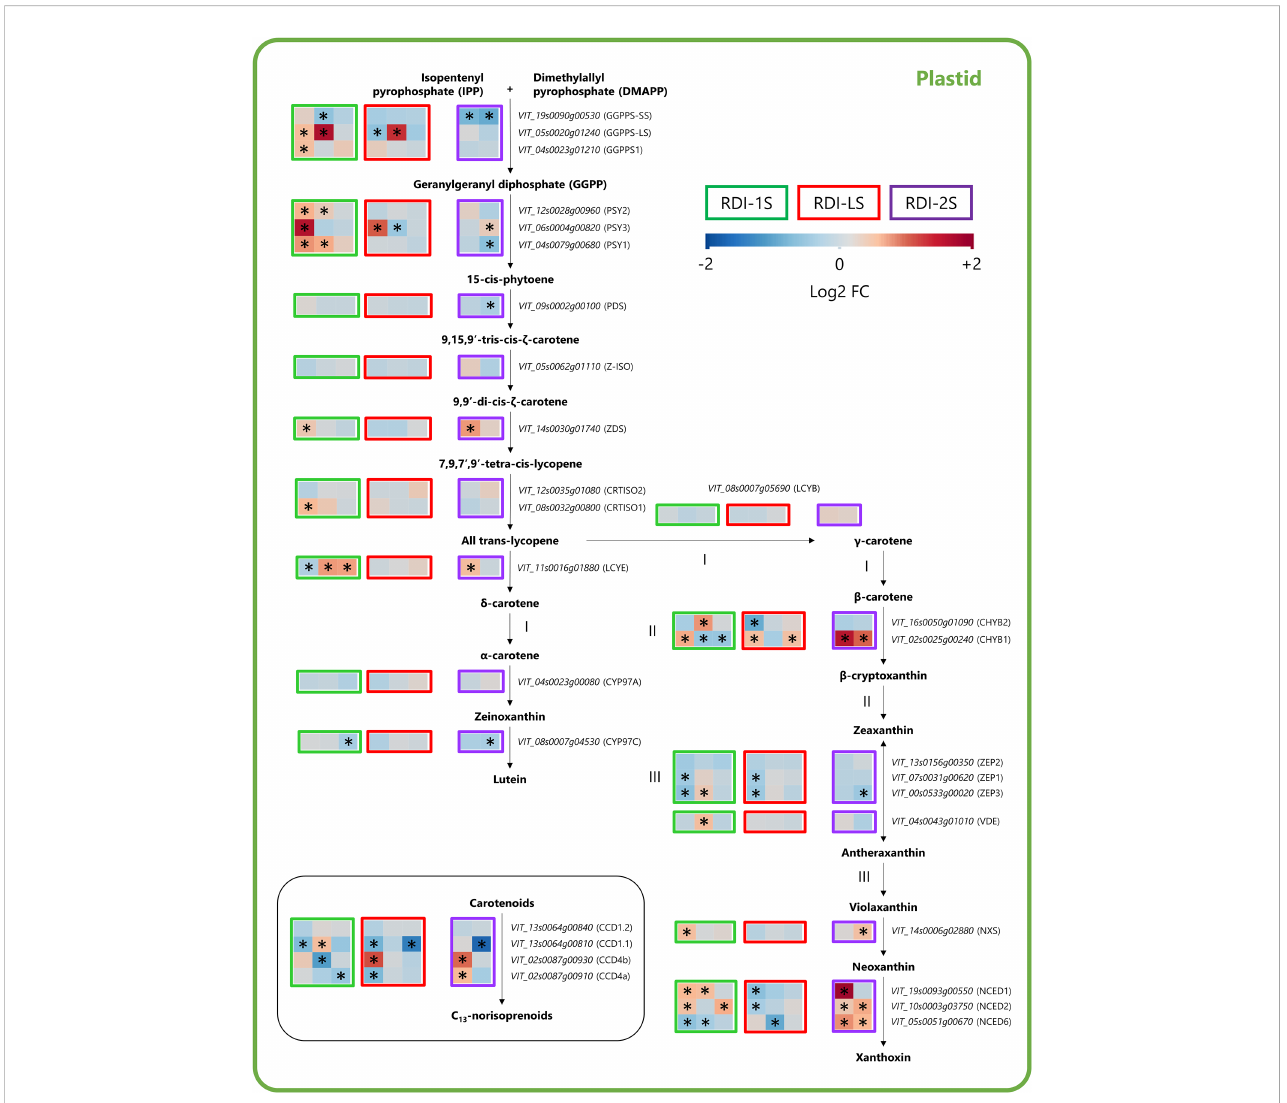
FIGURE 6 Modulation of the carotenoid pathway in berries of Sangiovese grapevines ( Vitis vinifera L.) subjected to different irrigation regimes: RDI-1S, severe water de fi cit applied from berry pea size to beginning of veraison (green block); RDI-LS, water de fi cit applied during lag phase (red block); RDI-2S, severe water de fi cit applied from beginning of veraison to harvest (purple block). Log2FC (RDI/FI) levels of differential gene expression are presented at the beginning of veraison (left box), mid-ripening (central box), and harvest (right box). Asterisks identify signi fi cant differences (p < 0.05) between treatments. Roman numbers indicate commonly regulated steps of the